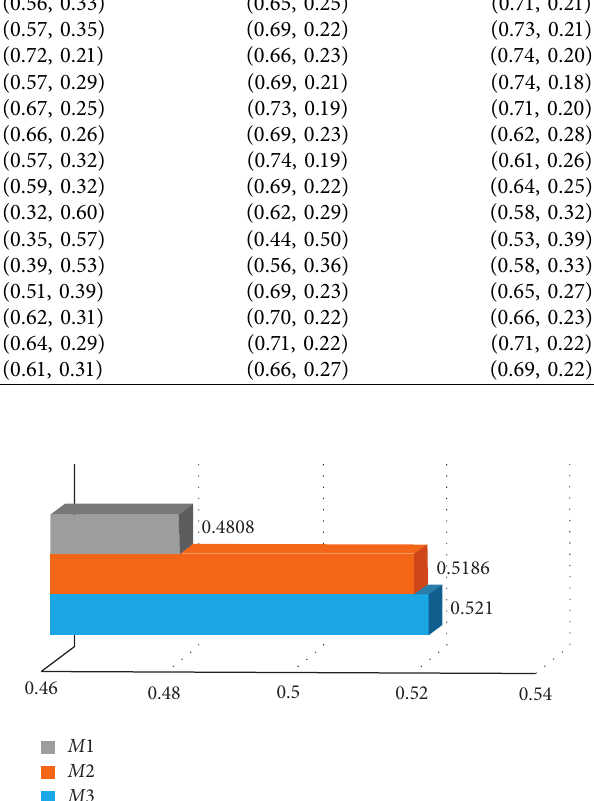
Figure 4: Comparison chart of the score function of the